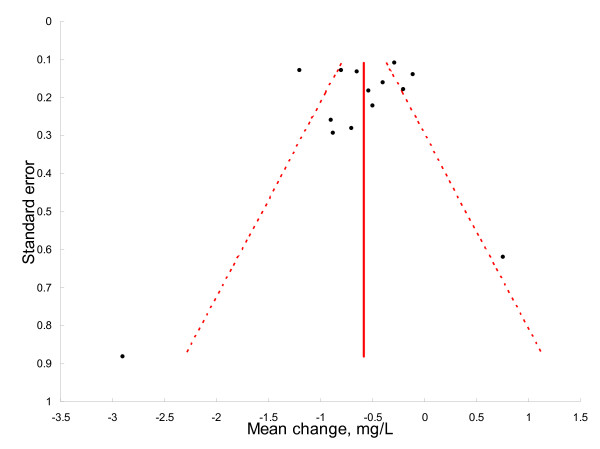
Funnel plot showing no evidence for publication bias.